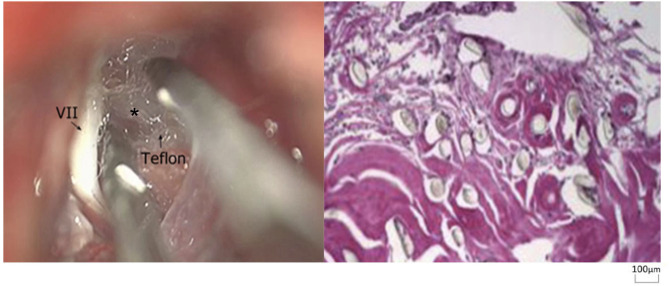
Teflon granuloma in redo MVD patients (hematoxylin and eosin staining, ×100). (VII, facial nerve; asterisk, granuloma).